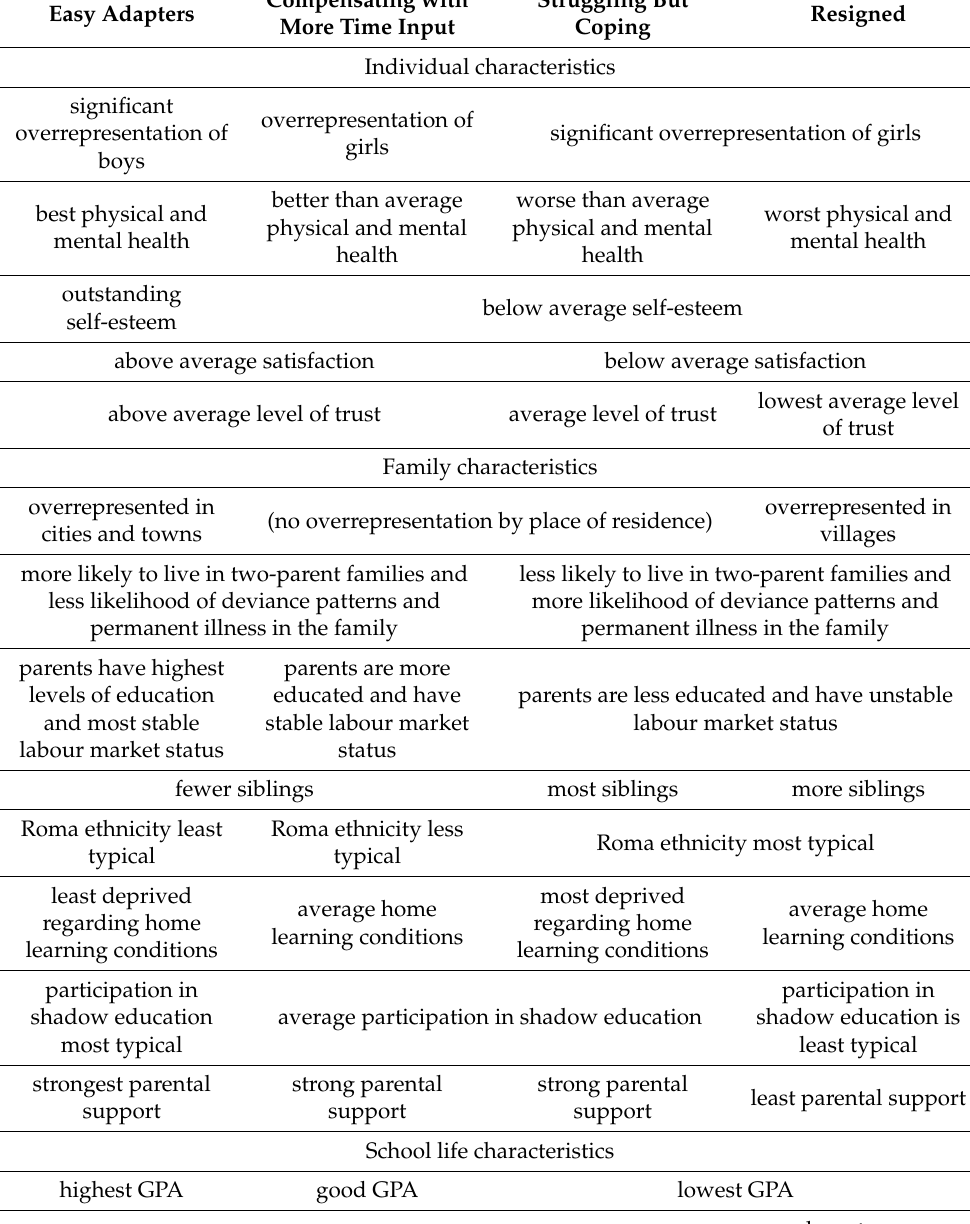
Table 6. Main differences between the student groups by individual, family and school